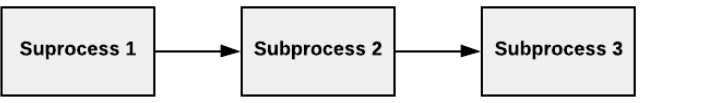
Figure 5. A generic flow chart of a process containing three linearly connected subprocesses.